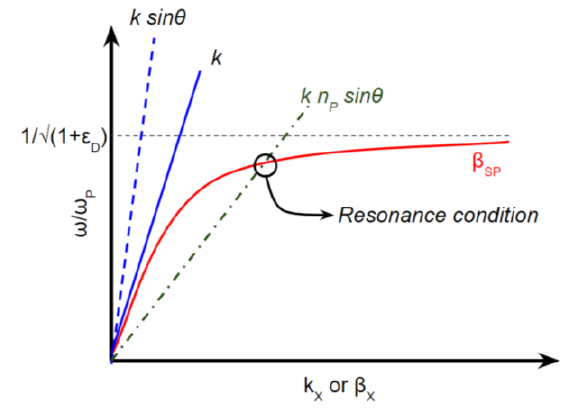
Figure 4. Dispersion relation of TM incident light coupling SP.